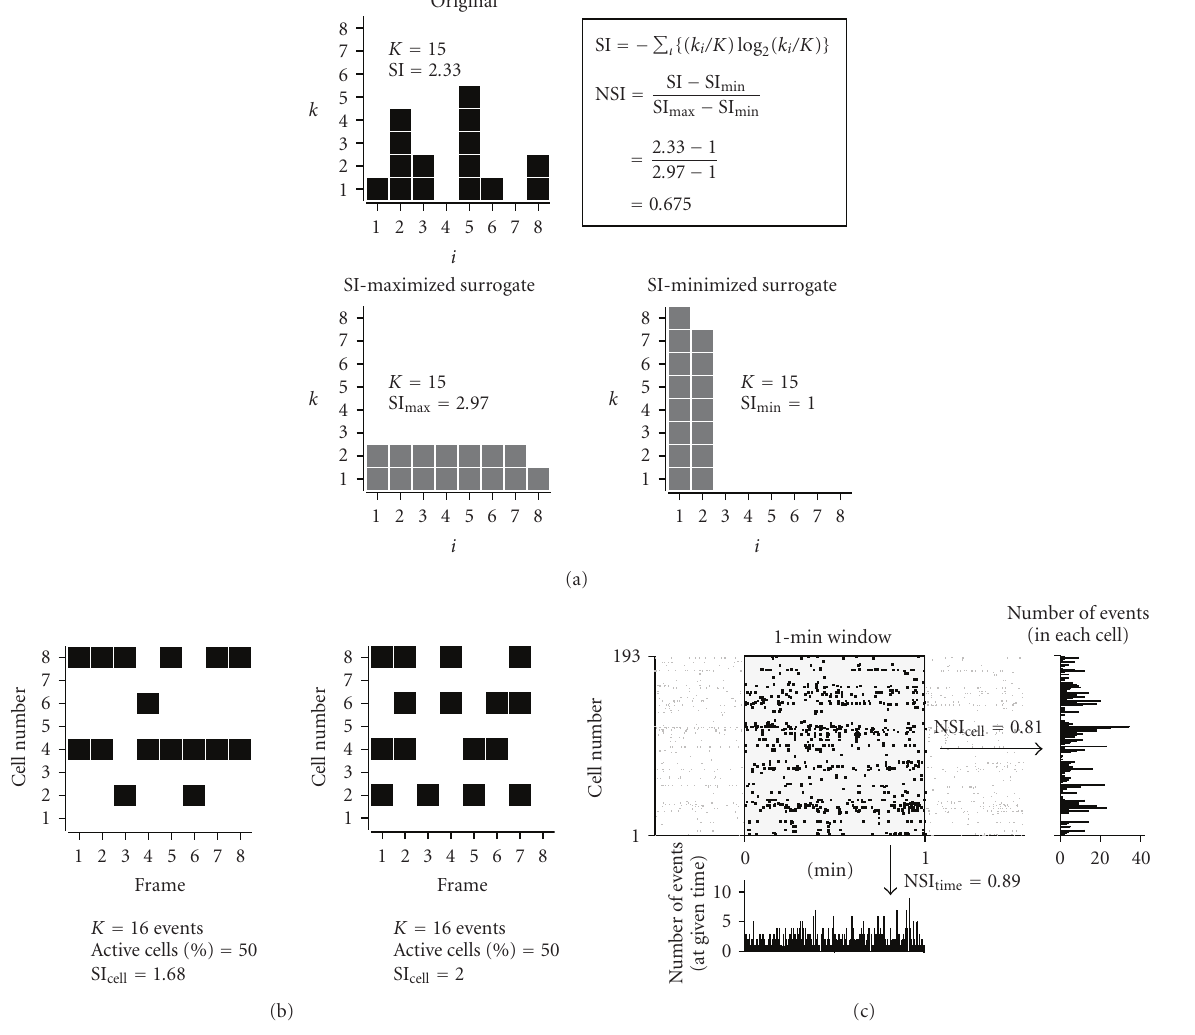
Figure 2: Diagram of entropy-based metrics to capture network activity patterns . (a) Shannon index (SI) is calculated with the Shannon entropy equation and normalized with its maximum and minimum values that can be taken through data shu ffl e with keeping the total number of events constant, as shown in the schematics. (b) SI can take di ff erent values depending on the pattern of activity, even when the numbers of activity events and active cells are invariant. (c) Example of the normalized SI (NSI) in multineuronal spike trains. A 1-minute window (shadow area) was placed at any given time on a rastergram. Two histograms were made by projecting the dataset to the vertical (right) and horizontal axes (bottom), so that NSIs evaluate the event dispersion in terms of space and time (NSI cell and NSI time ,